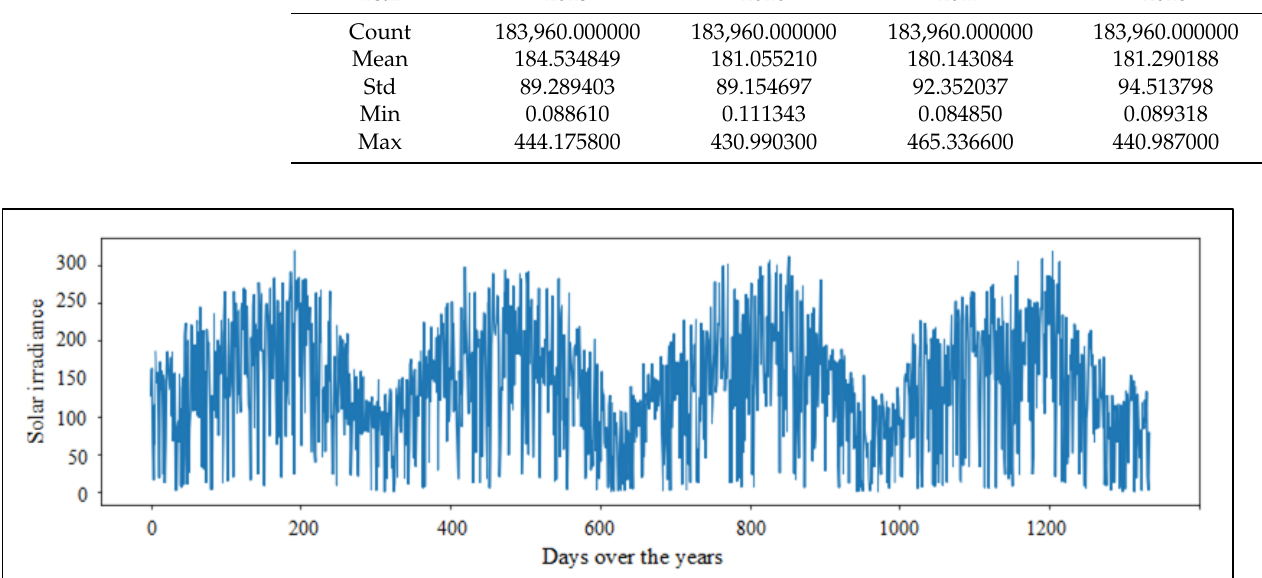
Figure 5. Visualization of solar irradiance values of a location sample of the years 2016–2018.